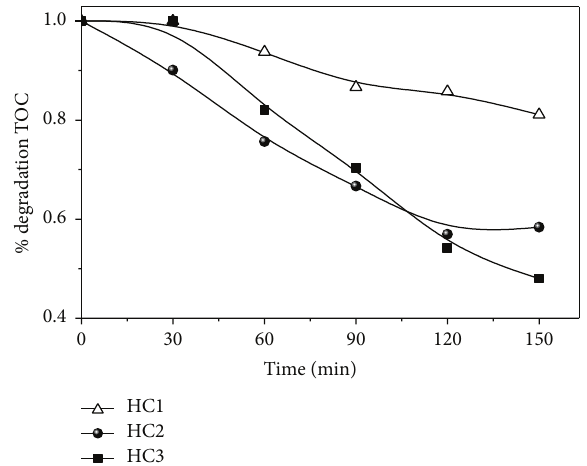
Figure10:DeterminationoftheTotalOrganicCarbon(TOC)ofthe 2,4-D photodegradation.